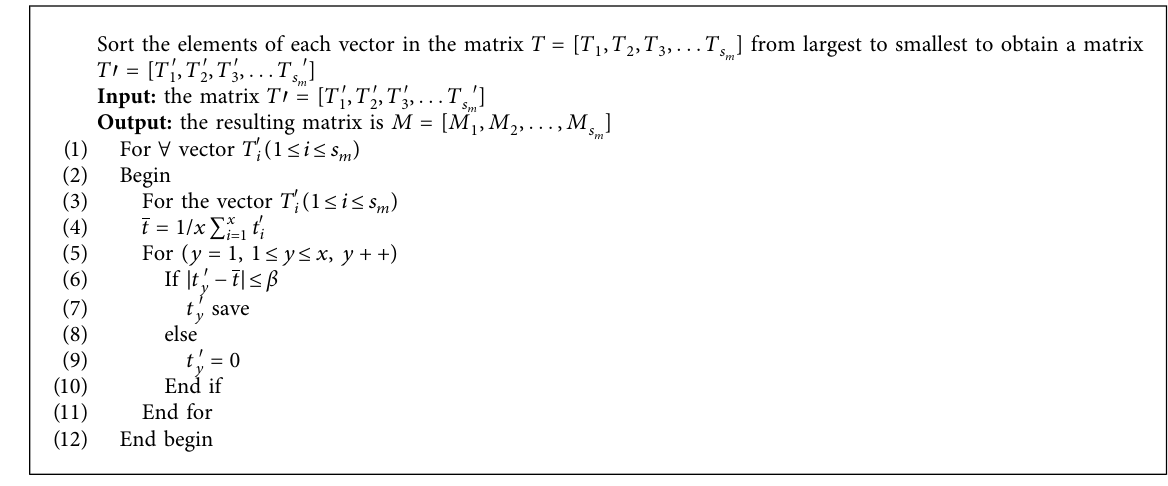
A LGORITHM 1: Algorithm for removing low-quality data in task grid.